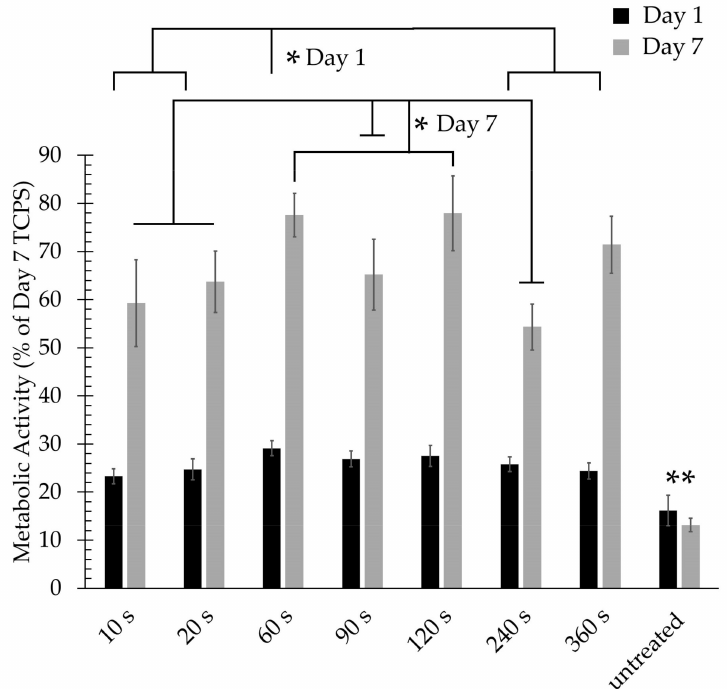
Figure 9. Cell viability 1 day and 7 days after cell seeding on pristine PCL NFs and PPF-NFs prepared using di ff erent plasma deposition times. The results are presented relative to the viability of TCPS on day 7 (* denotes statistical significance at * p < 0.05, ** p <